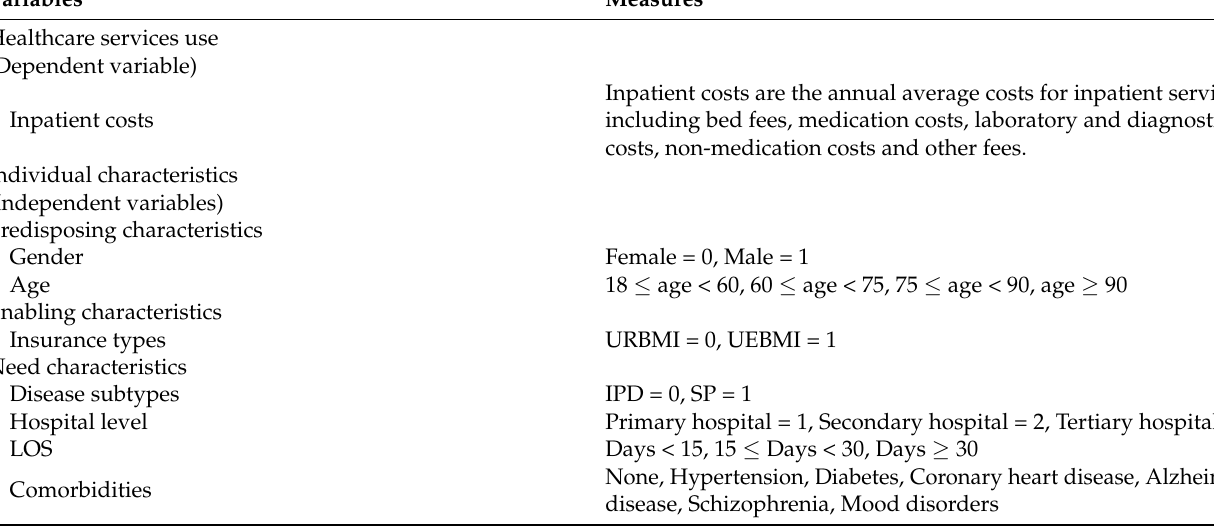
Table 3. Variables and